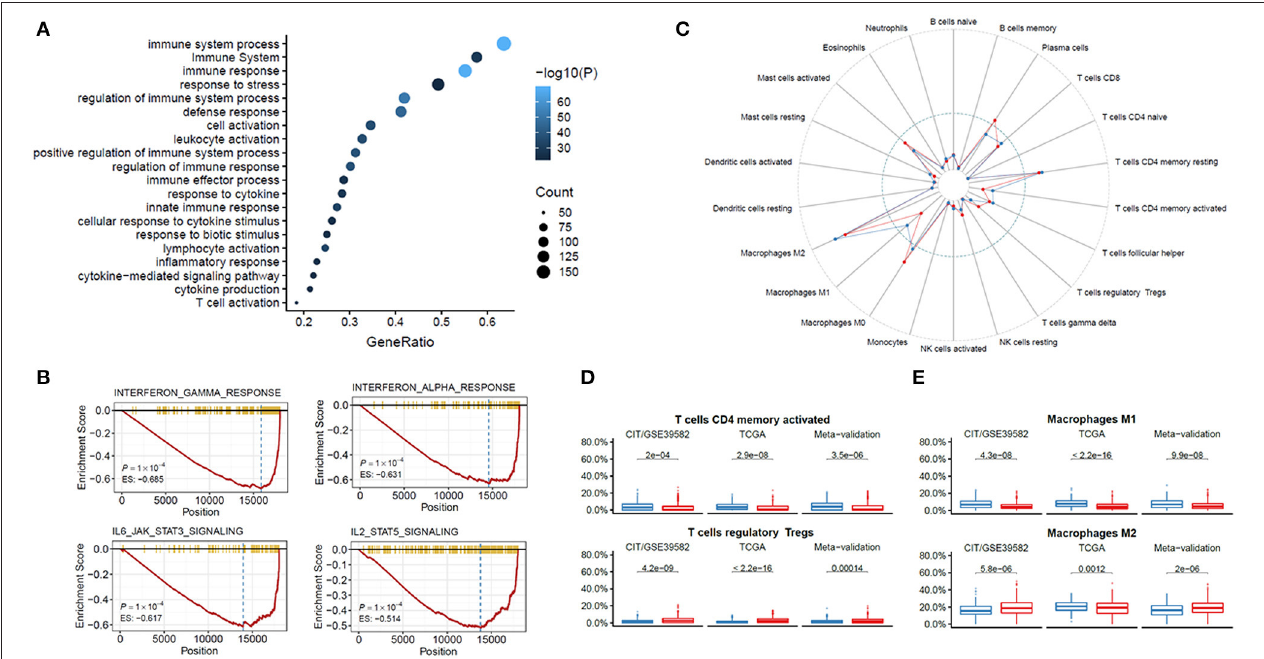
FIGURE 4 | Functional annotation of the HRGS. Enrichment analysis of the differentially expressed genes between risk groups in GO and KEGG (A) . GSEA showed IFN- α , IFN- γ , IL-6, and IL-2 were depressed in the high hypoxic risk patients (B) . Immune cells were assessed based on data from TCGA (C) . CD4T cells and M1 macrophages were depressed while T cells and M2 macrophages were enriched in the high hypoxia group (D,E) . P values comparing hypoxia high- and low-risk groups were calculated with t